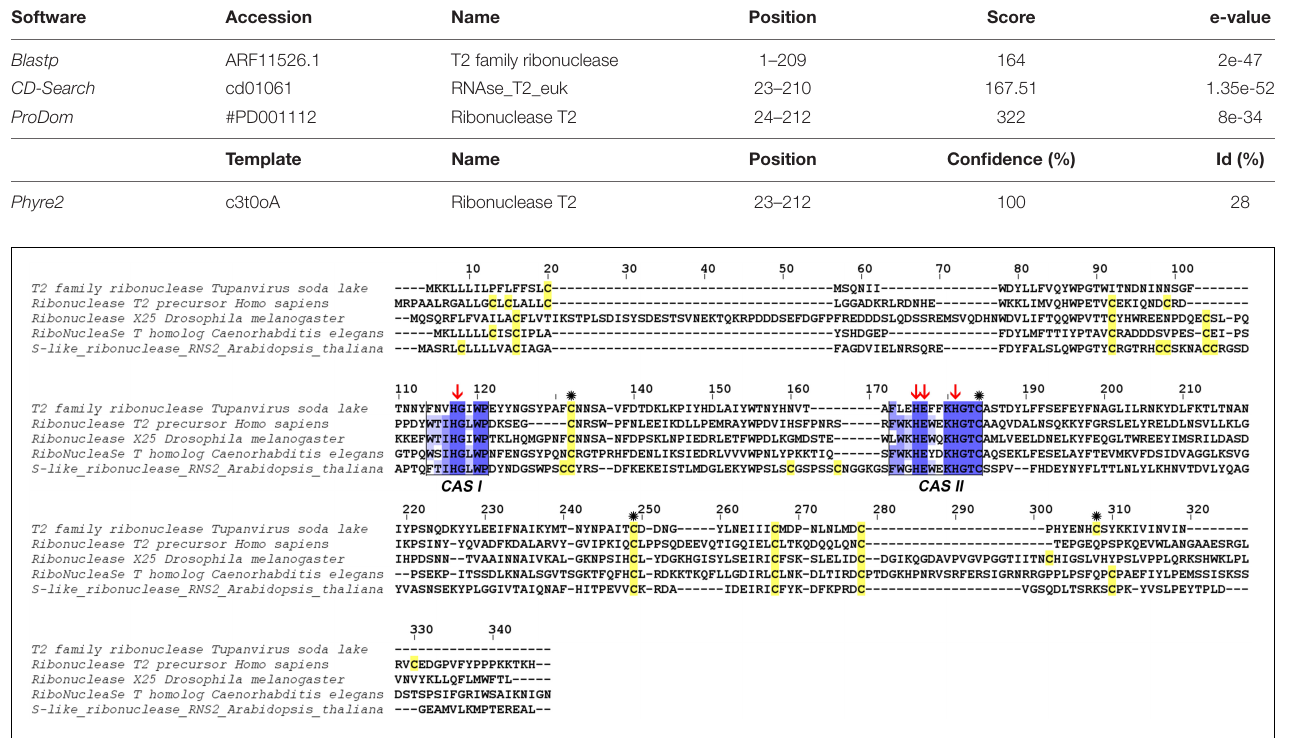
FIGURE 3 | Alignment of RNase T2 from Tupanvirus soda lake with reference eukaryote sequences. The two conserved CAS I and CAS II regions, characteristic of RNase T2 enzyme, are marked and conserved amino acids enlighten in blue (the intensity of color increase with the degree of conservation). Catalytic histidines are pointed with red arrows and cysteines are in yellow with those important for the active site marked with an asterisk.